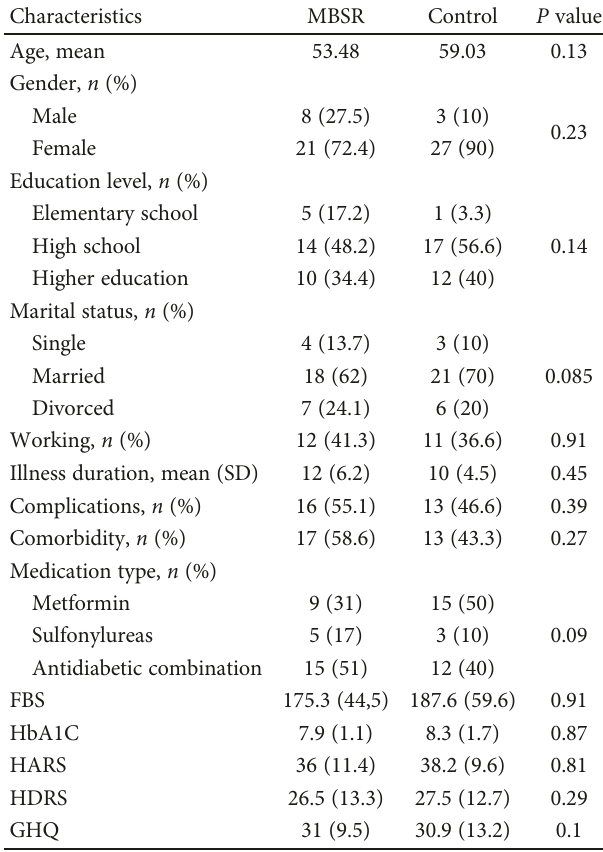
Table 1: Baseline demographic and clinical characteristics of the sample of patients with type 2 diabetes who were participated in the